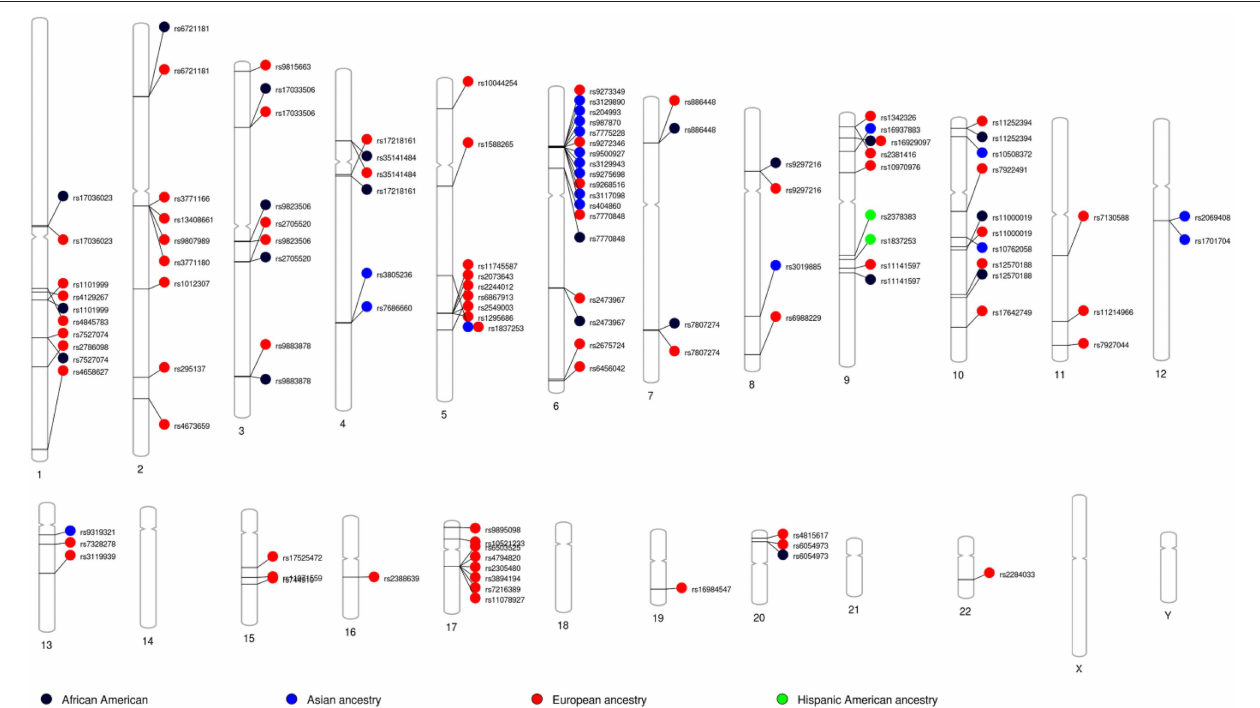
FIGURE 4 | Asthma GWAS catalog variants grouped by ancestry: Asthma related variants identified through genome-wide association studies (GWAS) NHGRI catalog of published GWAS was searched. PhenoGram was used to plot and visualize GWA catalog association results for potentially pleiotropic SNPs among across ancestry (Wolfe et al., 2013). An Ideogram of all 22 chromosomes is plotted, along with the X and Y chromosomes. Lines are plotted on the chromosomes corresponding to the base-pair location of each asthma-related SNP, and the line connects to colored shape representing the phenotype(s) associated with that